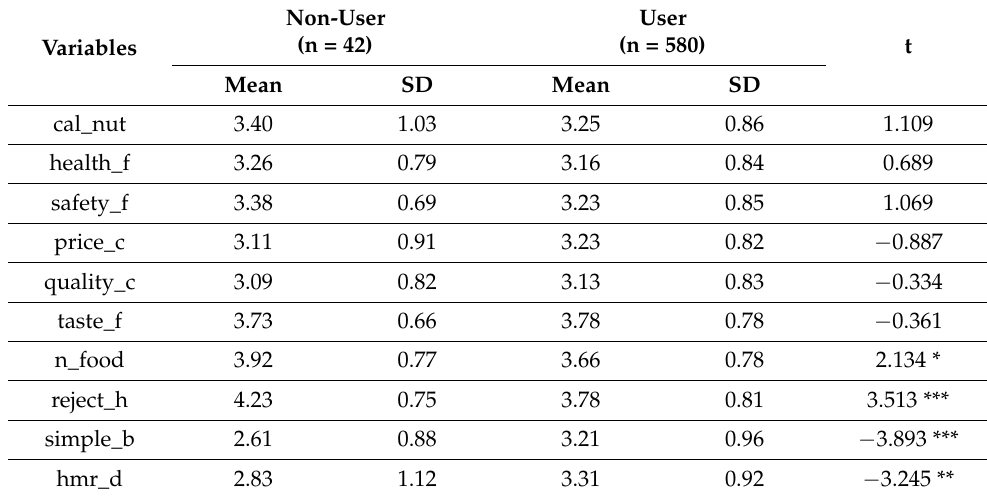
Table 5. Difference in FCBs between non-users and users of social media.